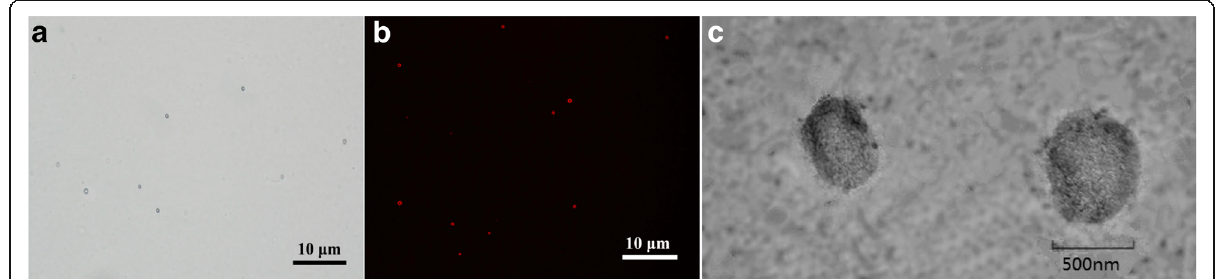
Fig. 1 NBs observed under a light microscope (magnification × 1000) ( a ) and the fluorescence microscope image of DOX-loaded NBs ( b ) and TEM image of DOX-loaded NBs ( c )